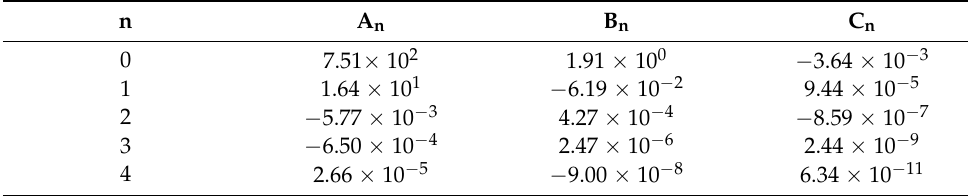
Table A12. Coefficients of the H 2 O-LiBr + LiNO 3 density